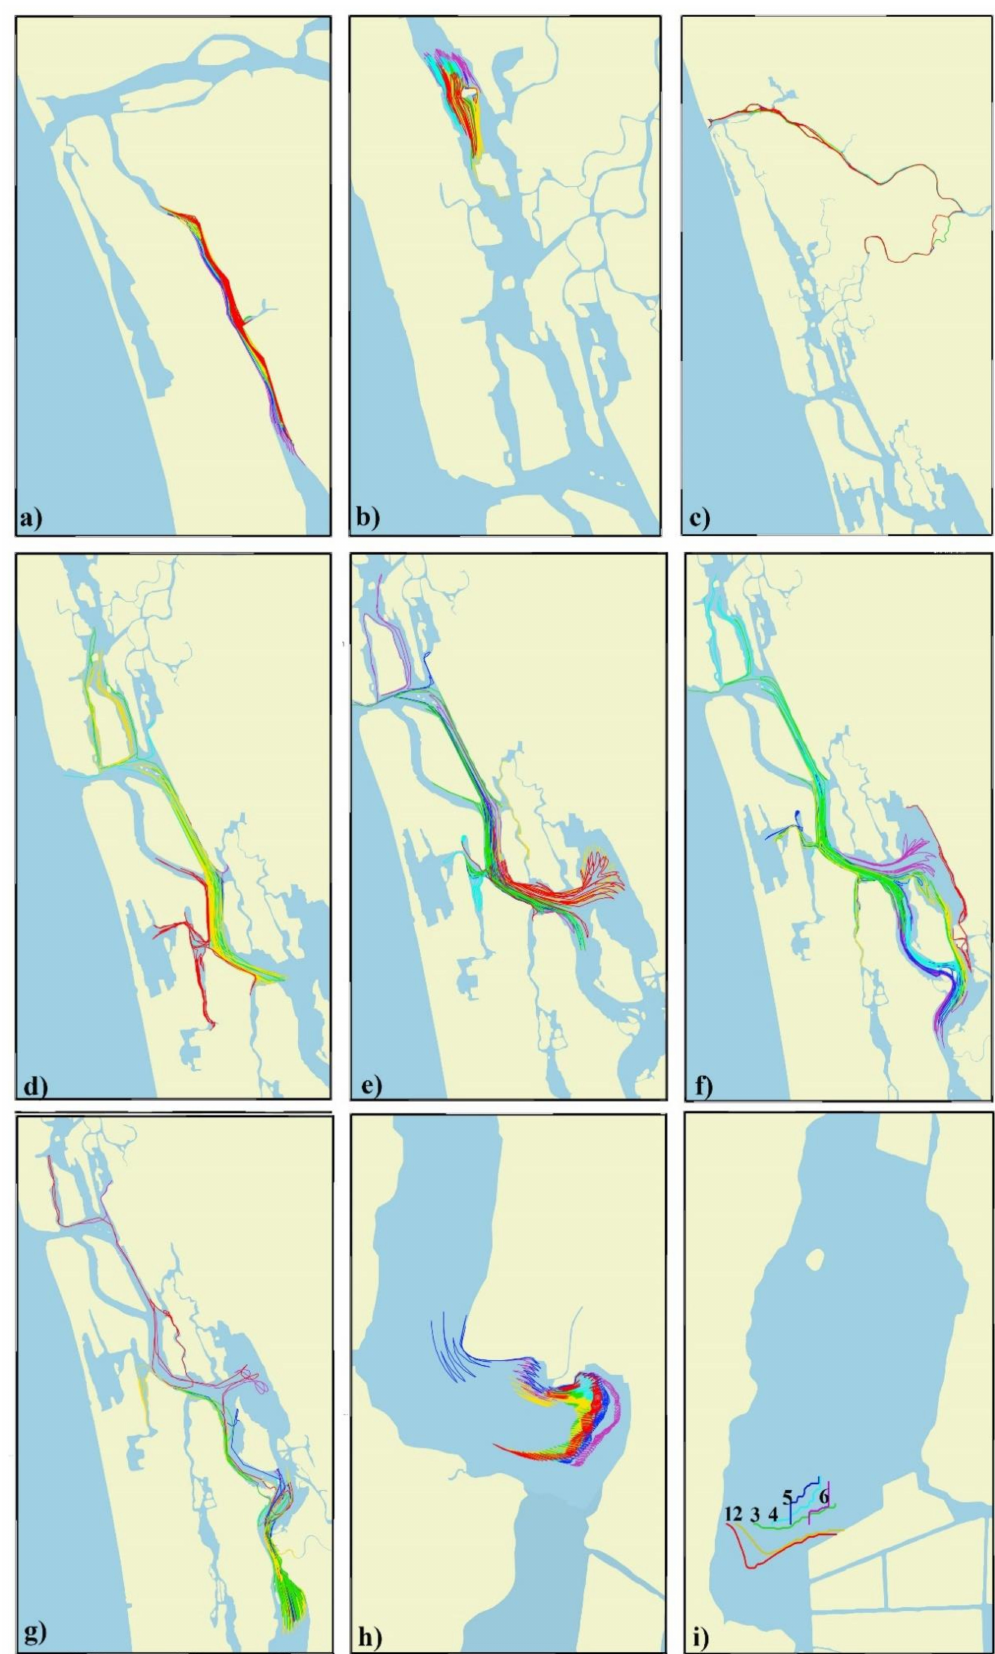
Figure 22. Trajectories of the particles released at nine locations as mentioned in the Table 5 ( a – i ) during the pre-monsoon period is shown as Red (1), yellow (2), green (3), cyan (4), blue (5) and magenta (6) according to its lateral